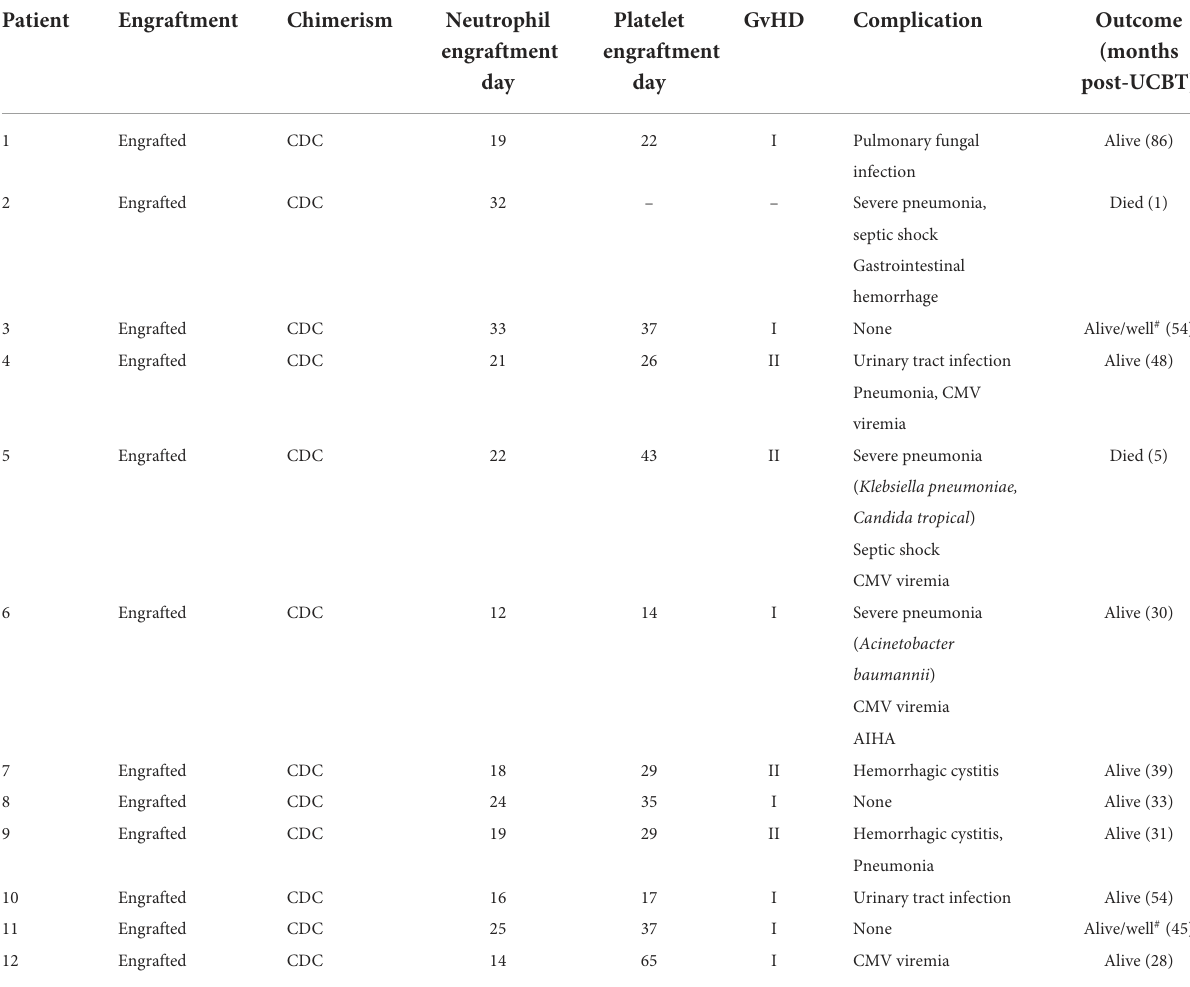
TABLE 3 Outcomes and complications of